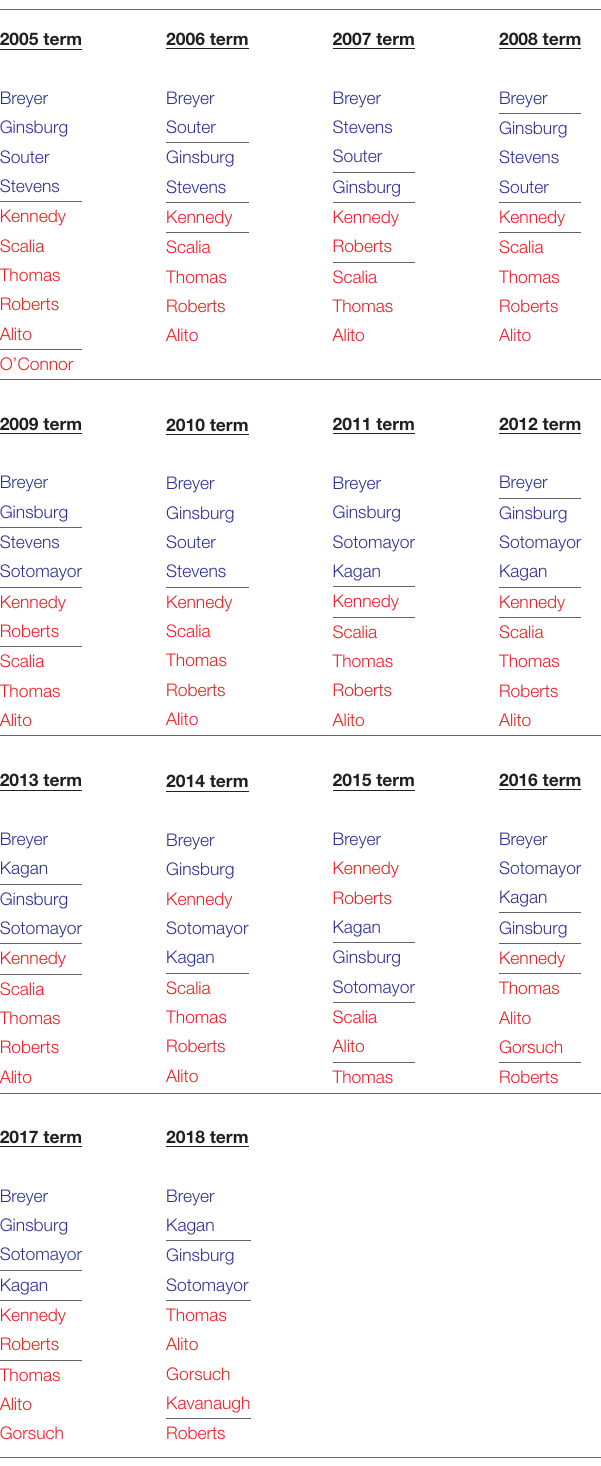
Conservative judges are listed in red and the liberal justices are listed in blue. singleton in the second position. Kennedy and Roberts form the third position. To the extent they are in a bridging role, it is extremely weak as they have modest positive